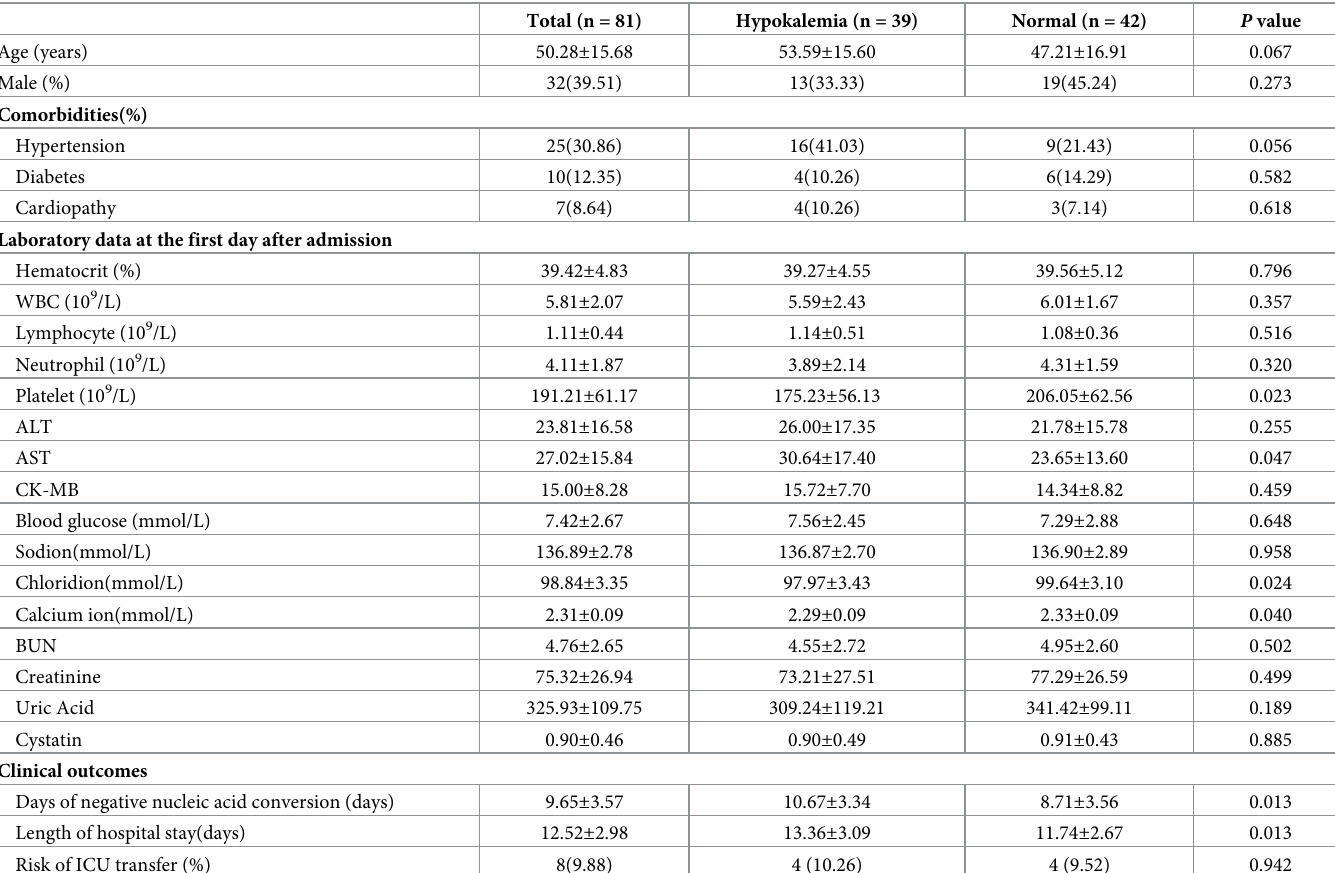
Table 1. Data of the included patients with moderate COVID-19.